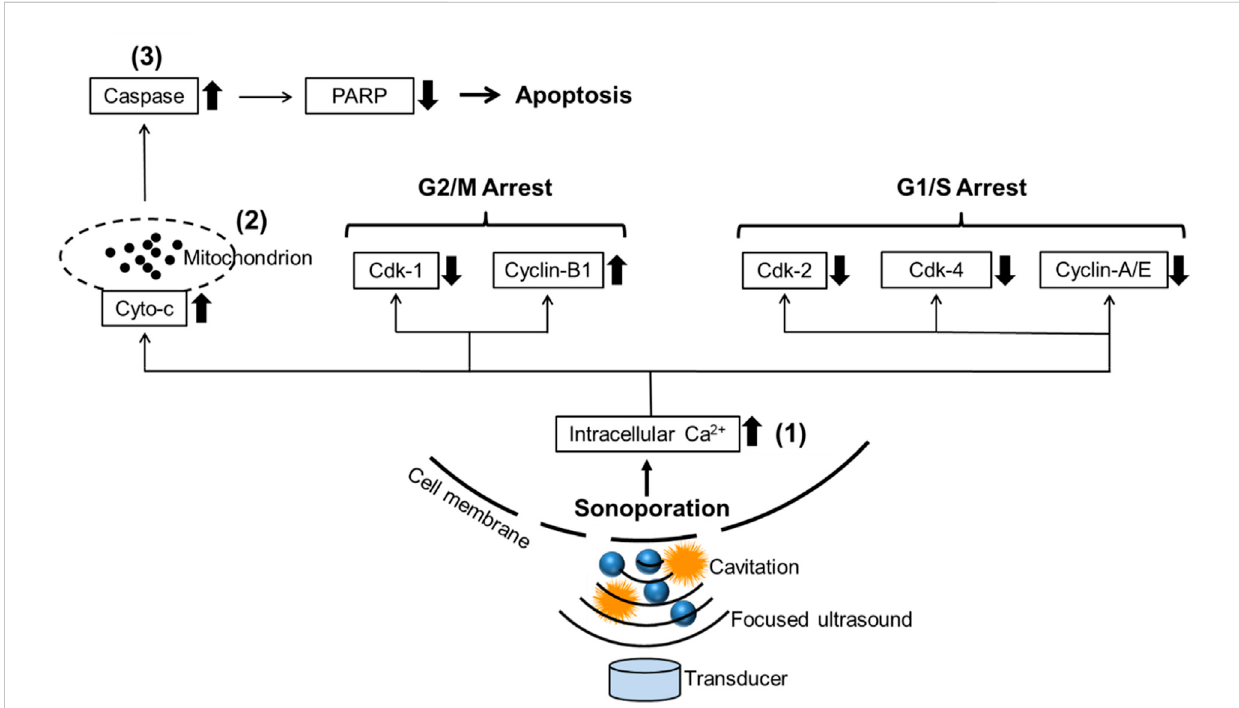
FIGURE 8 Schematic diagram reveals the potential mechanism of sonoporation-induced cell apoptosis and cell-cycle arrest. The transduction of intracellular signaling molecules involves 1) intracellular Ca 2+ signaling system, 2) mitochondrion biology, and 3) apoptosis signaling pathway. Cyto-c: cytochrome c, PARP: polyadenosine diphosphate ribose polymerase, Cdk: Cyclin-dependent kinases. Adapted from (Zhong et al.,